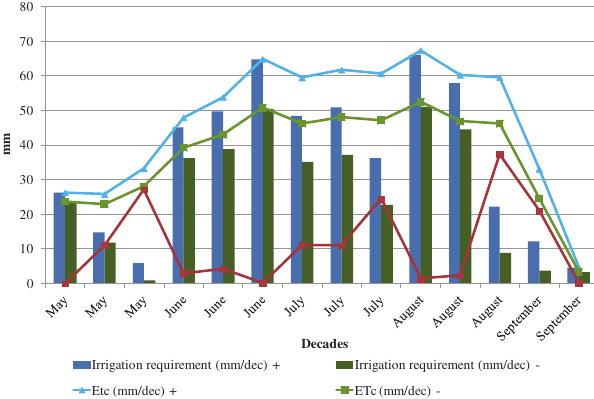
Figure 3. Irrigation requirement and evapotranspiration of Sweet Lady in 2003 (+: with active ground cover, –: bare soil)